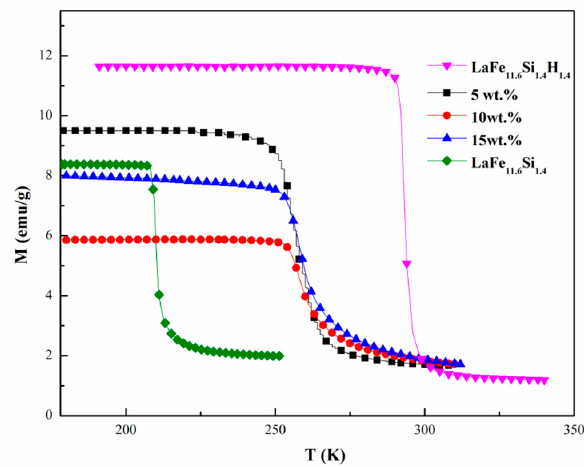
Figure 4. Temperature dependence of magnetization measured under 0.01 T for LaFe 11.6 Si 1.4 H y /Bi composites with different low-melting alloy contents and LaFe 11.6 Si 1.4 compound.